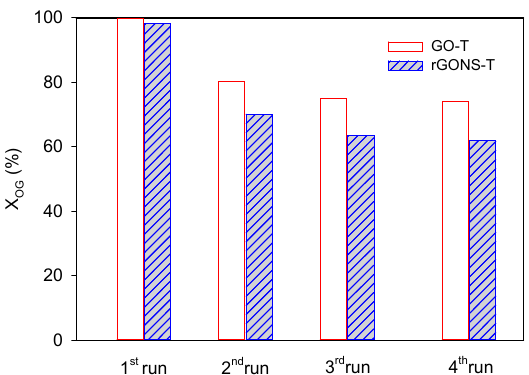
Figure 8. Reusability of the GO-T and rGONS-T photocatalysts for the OG degradation during four consecutive runs.